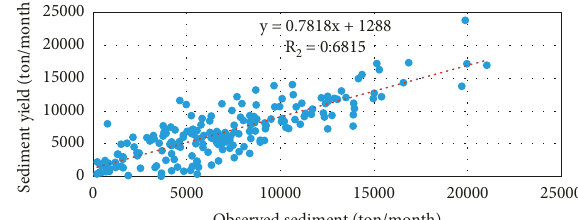
Figure 14: Monthly validated sediment yield hydrograph at the Awata station.